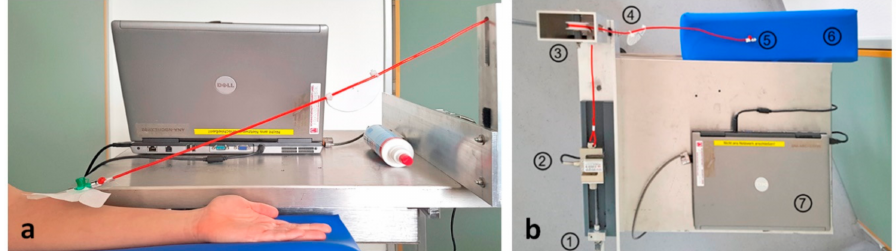
Figure 2. Experimental setup: ( a ) cord attached to truncated cannula; ( b ) view from above: 1, crank handle; 2, force transducer; 3, deflection roller; 4, angle meter; 5, Luer lock connector; 6, arm rest; 7, laptop for data